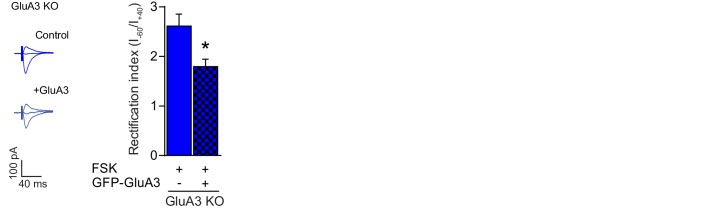
Sindbis viral GFP-GluA3 expression predominantly traffic into CA1 synapses in configuration of GluA2/3 heteromers.Example traces and average rectification indices ([I-60mV – I0mV) / (I+40mV – I0mV]) were determined in uninfected (n=8) or GFP-GluA3 infected (n=8) CA1 neurons from GluA3-KO organotypic slices in the presence of forskolin (t-test, p=0.01). Error bars indicate SEM, * indicates p<0.05.